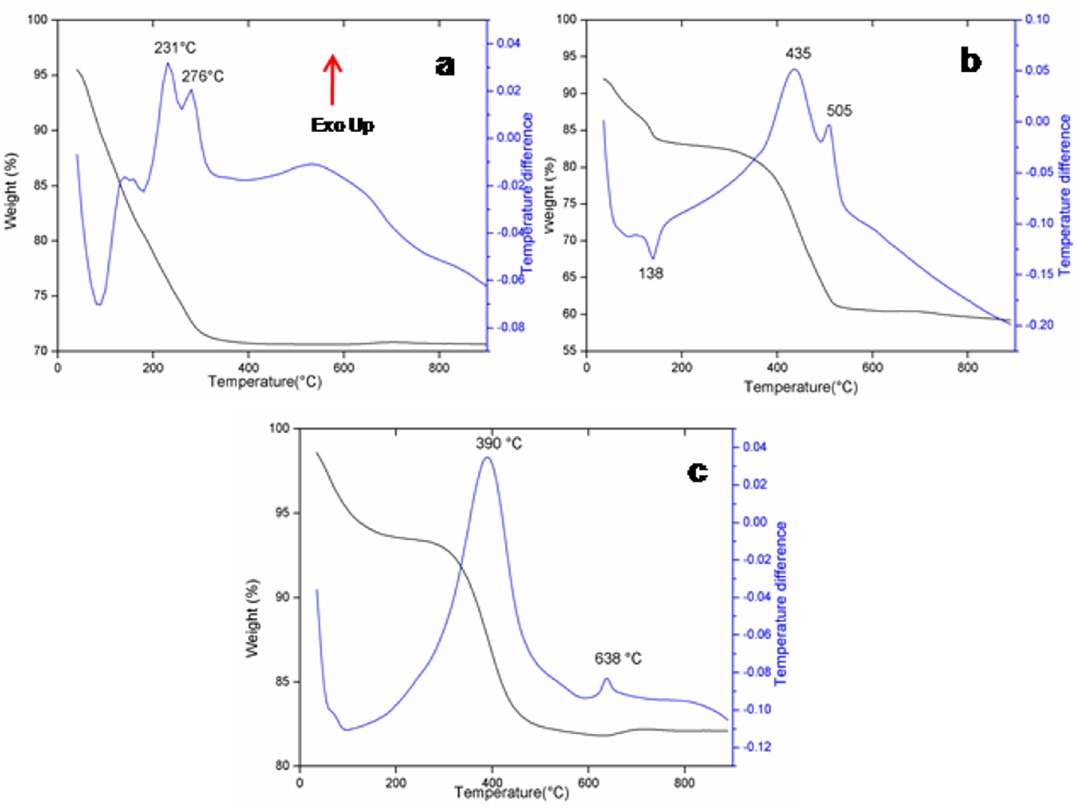
(b) CoTiO and (c) NiTiO at a heating rate of 10ºC/min from room temperature at 900 ºC, under 3 3 3 2